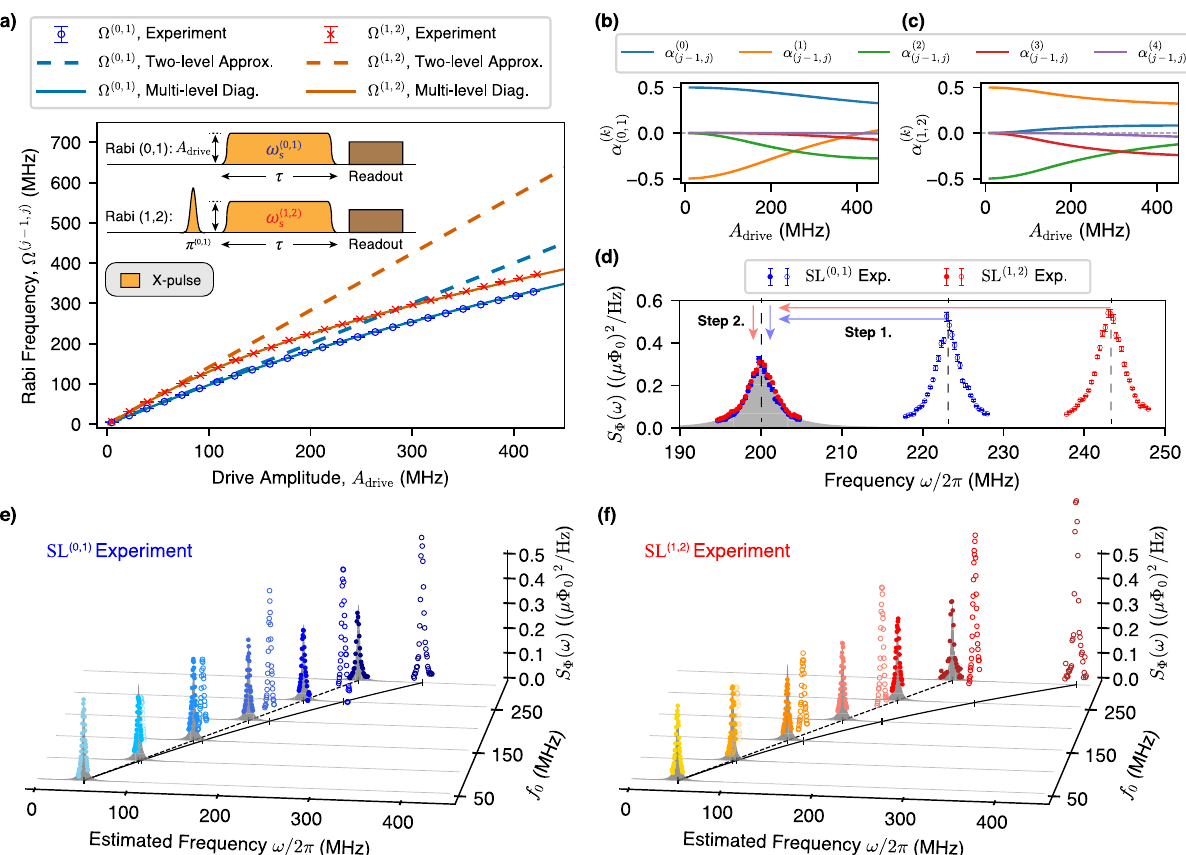
Fig. 3 Accurate spectral estimation of high-frequency noise. a Rabi frequencies Ω ( j − 1, j ) for 0 j i – 1 j i (blue) and 1 j i – 2 j i (red) transitions as a function of the drive amplitude A drive . Inset: pulse sequences used to measure the Rabi frequencies. b – c Numerical calculations of noise participation ratios α ð k Þ ð j (cid:2) function of drive amplitude A drive . d Spectral estimation of the engineered fl ux noise (Lorentzian, centered at 200 MHz) via SL (0,1) (blue) and SL (1,2) (red) experiments. Two corrections are applied to the estimates under the two-level approximation (hollow circles), and consist of shifting the frequency (step 1) and adjusting the magnitude (step 2) due to the multi-level dressing. Note that the corrected fl ux noise spectra for SL (0,1) (blue circles) and SL (1,2) (red circles) are in good agreement with the ideal fl ux noise PSD (gray fi lled). Error bars represent ±1 standard deviations. e , f Benchmarking the spectral estimation of engineered fl ux noise ranging from f 0 = 50 MHz to f 0 = 300 MHz, where f 0 corresponds to the center frequency of engineered noise spectra. The different color shades of the PSD estimates correspond to engineered fl ux noise with different center frequencies. The agreement between the corrected experimental estimates (circles) and the ideal fl ux noise PSDs (gray fi lled) indicates that our protocol overcomes the spectral limit imposed by the sensor shading) with the corrected fl ux noise PSD estimates (circles sitting on the envelope of the gray regions and following a dashed line) measured by SL (0,1) (blue shades) and SL (1,2) (red shades), respectively, and with the uncorrected estimates ( “ x ” shapes following a solid line) that deviate in both the inferred frequency and power. The different colors correspond to the different